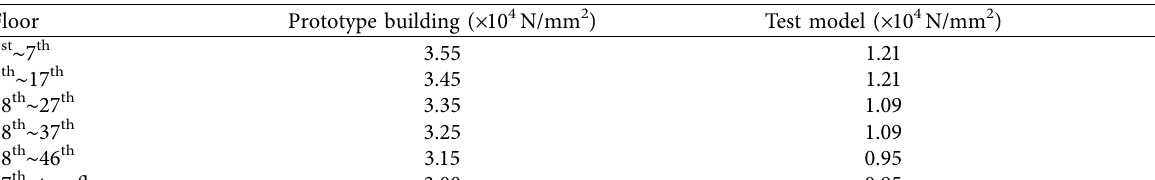
Table 4: Elastic modulus of